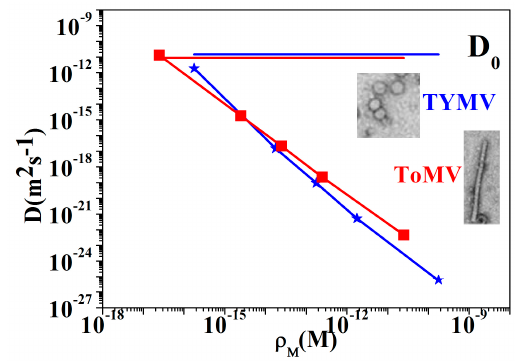
Figure 7. Comparison between translational diffusion coefficients ( D ) extracted from Warburg impedance (Equation (6)) at different virus molar concentrations of ToMV (red squares symbols and lines) and TYMV (blue stars symbols and lines) and the corresponding theoretically-expected ones for nanoparticles diffusion driven by Brownian forces D t,B = D 0 (from Equations (7b) and (8b)) (horizontal lines red ToMV, blue TYMV).